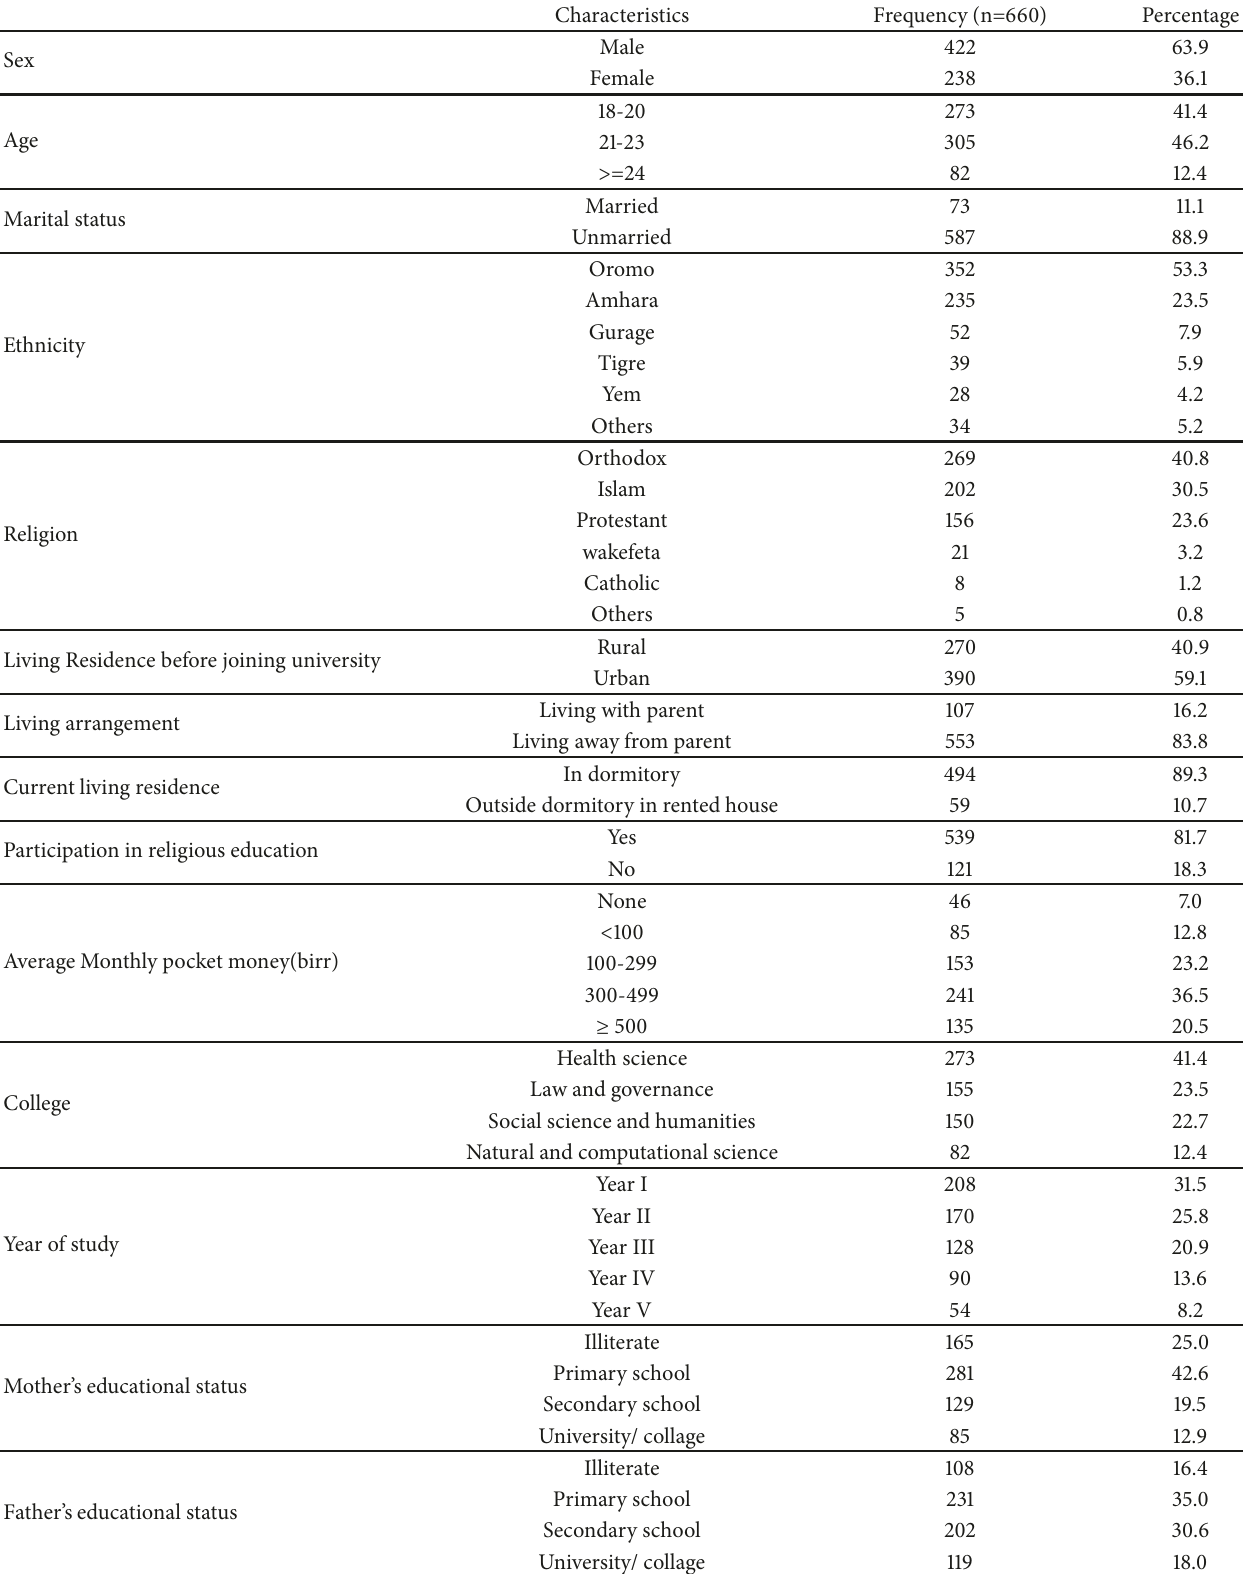
Table 1: Socio demographic, economic, and academic and parent’s characteristics of Jimma University students, April,